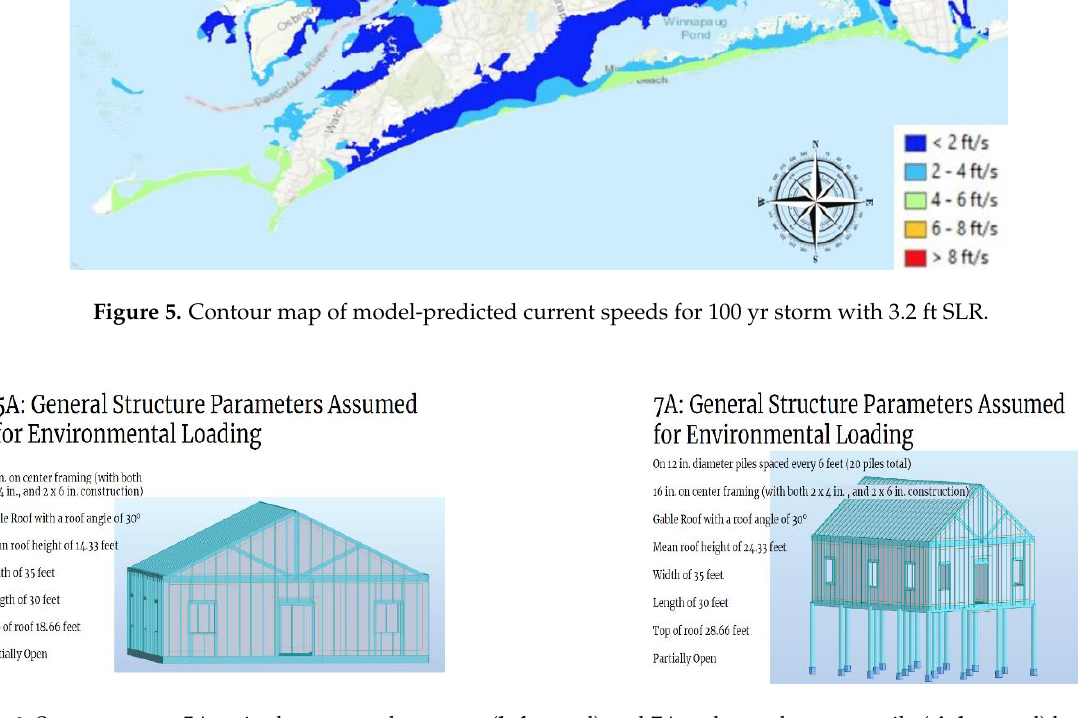
Figure 6. Structure type 5A—single story, no basement ( left panel) and 7A—elevated on open pile ( right panel) based on USACE NACCS classification [7,8]. Details on structure sizes and wood framing are also provided [15].